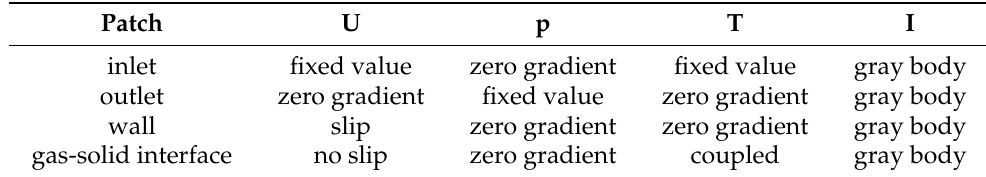
Table 2. Summary of boundary conditions.